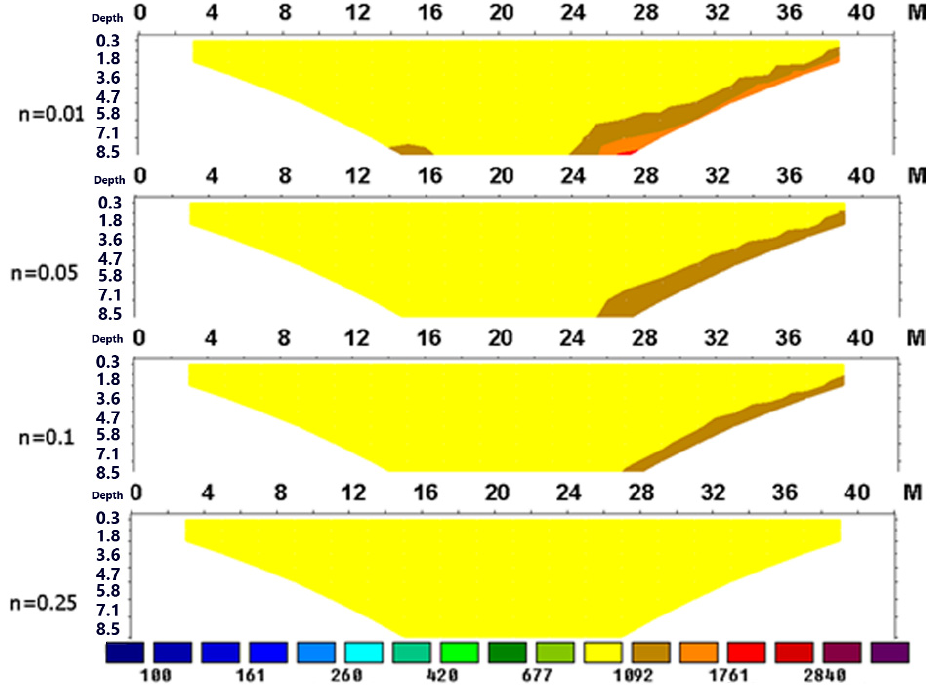
Figure 9. The influence situation of the boundary effect with different resistivity ratios.